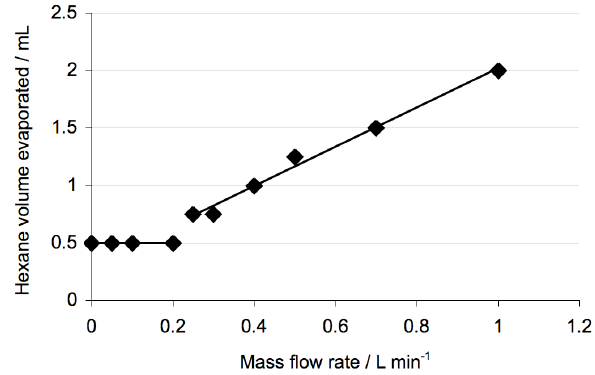
Fig. 5. Volume of hexane lost over 60min at a trapping temperature of − 50 ◦ C, as a function of nitrogen flow rate.